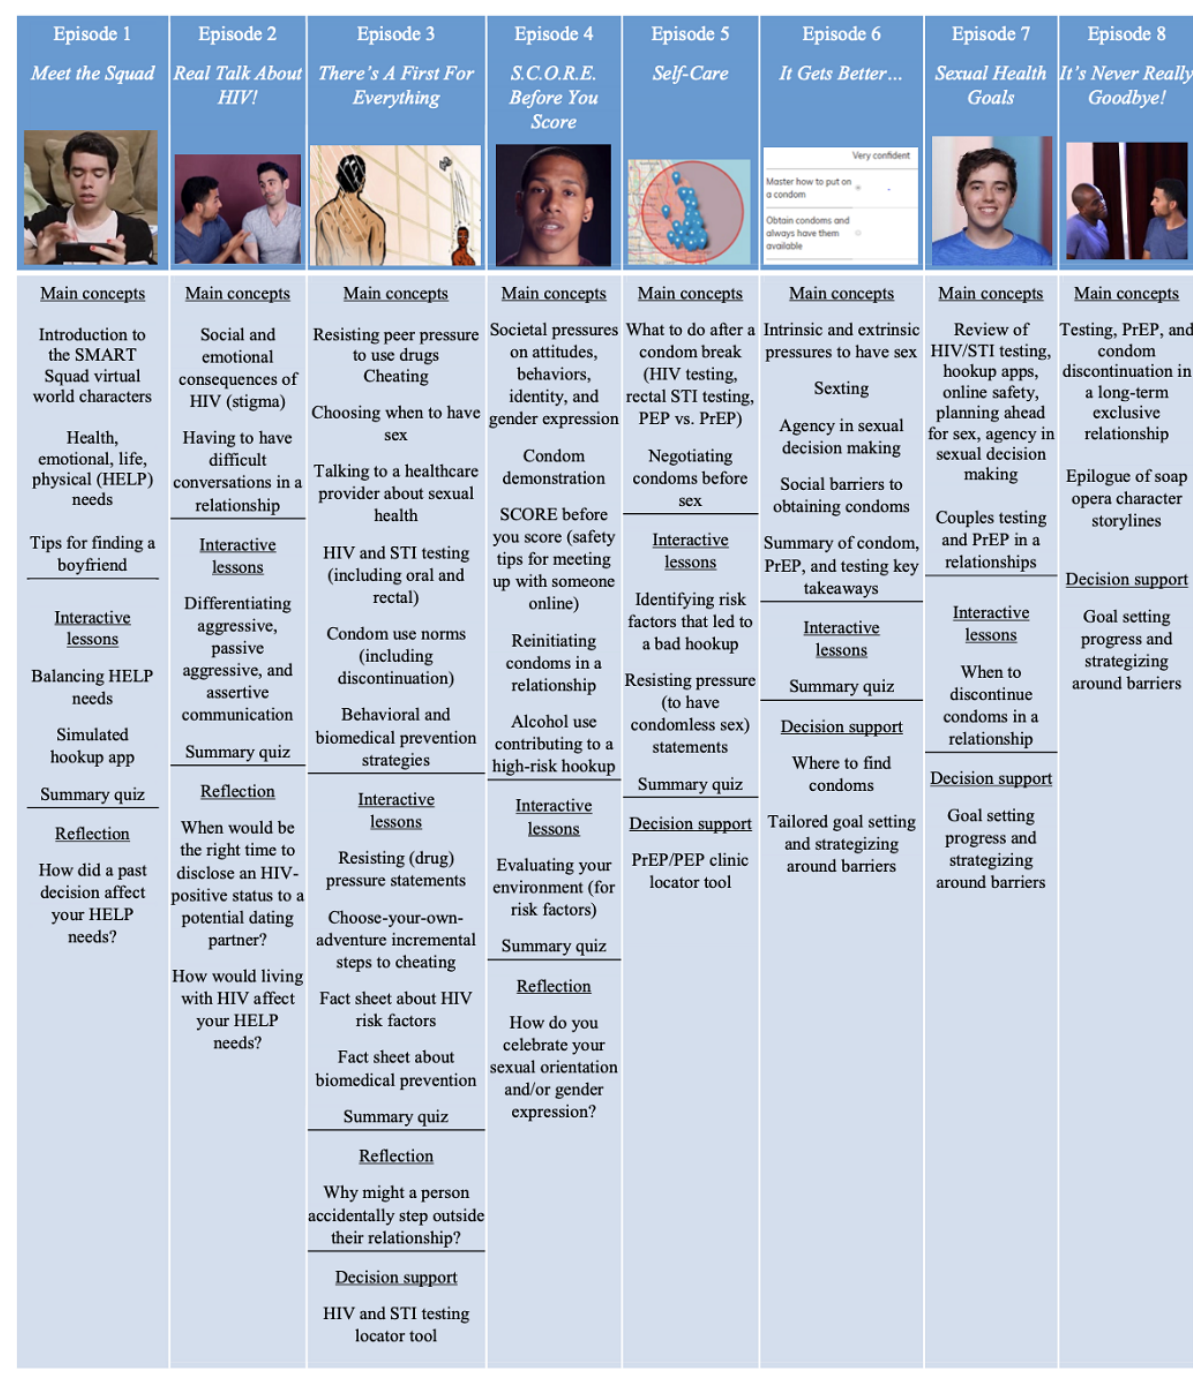
Figure 4. Overview of the 8 SMART Squad episodes: main concepts and active learning components. Main concepts refer to learning objectives or topics covered by episodes. Interactive lessons refer to activities that provide positive motivations and skills for sexual health. Reflection refers to open-ended questions asked of participants as an activity within an episode. Decision support refers to skills-based activities to identify solutions